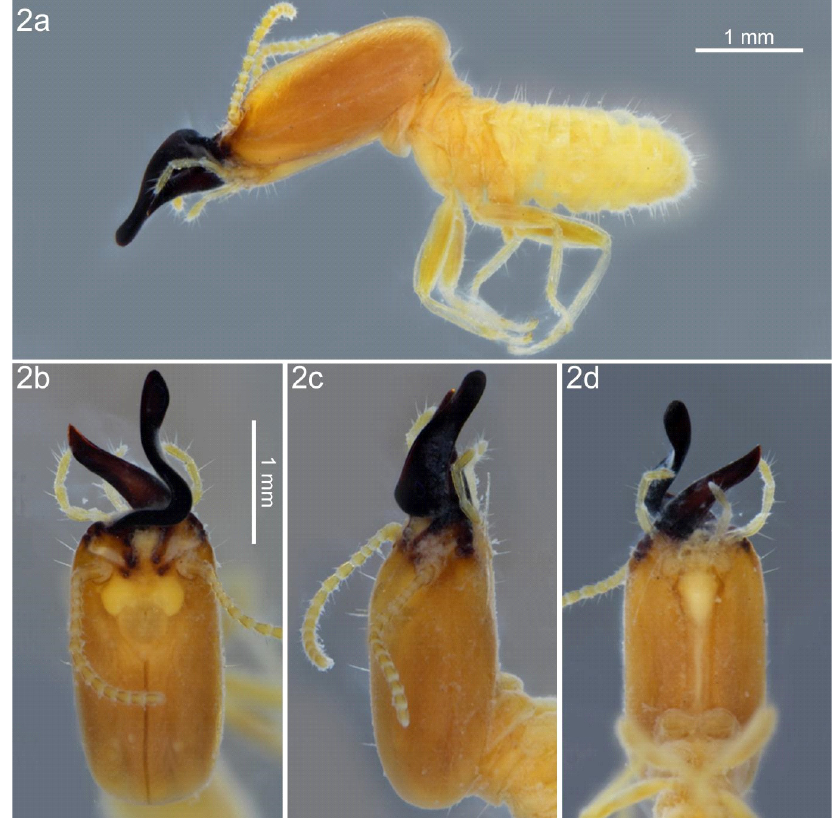
Fig 2 . Pericapritermes ceylonicus (Holmgren) soldier (AMNH metatype): a) Lateral view of body; b) Lateral view of head; c) Ventral view of head; d) Dorsal view of